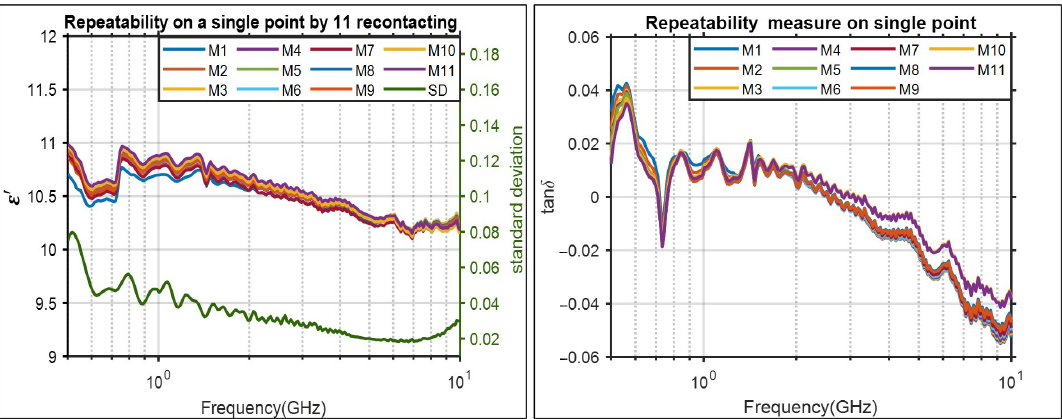
Figure 6. Repeatability evaluation of the permittivity measurements. Recontacting is performed 11 times and 30 measure- ments are conducted each time. Each of the 11 curves is the mean of the 30 measurements. The standard deviation of the 11 measurements is calculated and depicted as